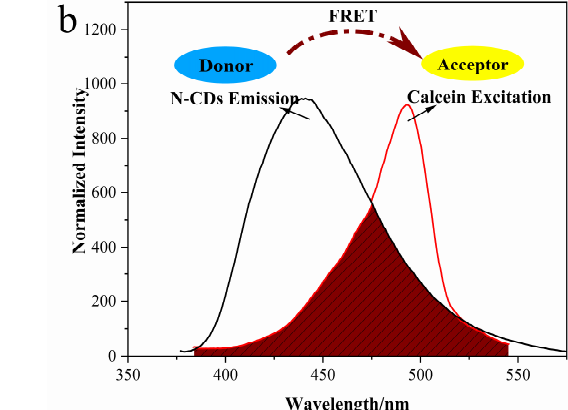
Figure 5. The corresponding fluorescence spectra and pictures under UV light (the inset) with different ratios of N-CDs and calcein in the N-CD/calcein mixture.